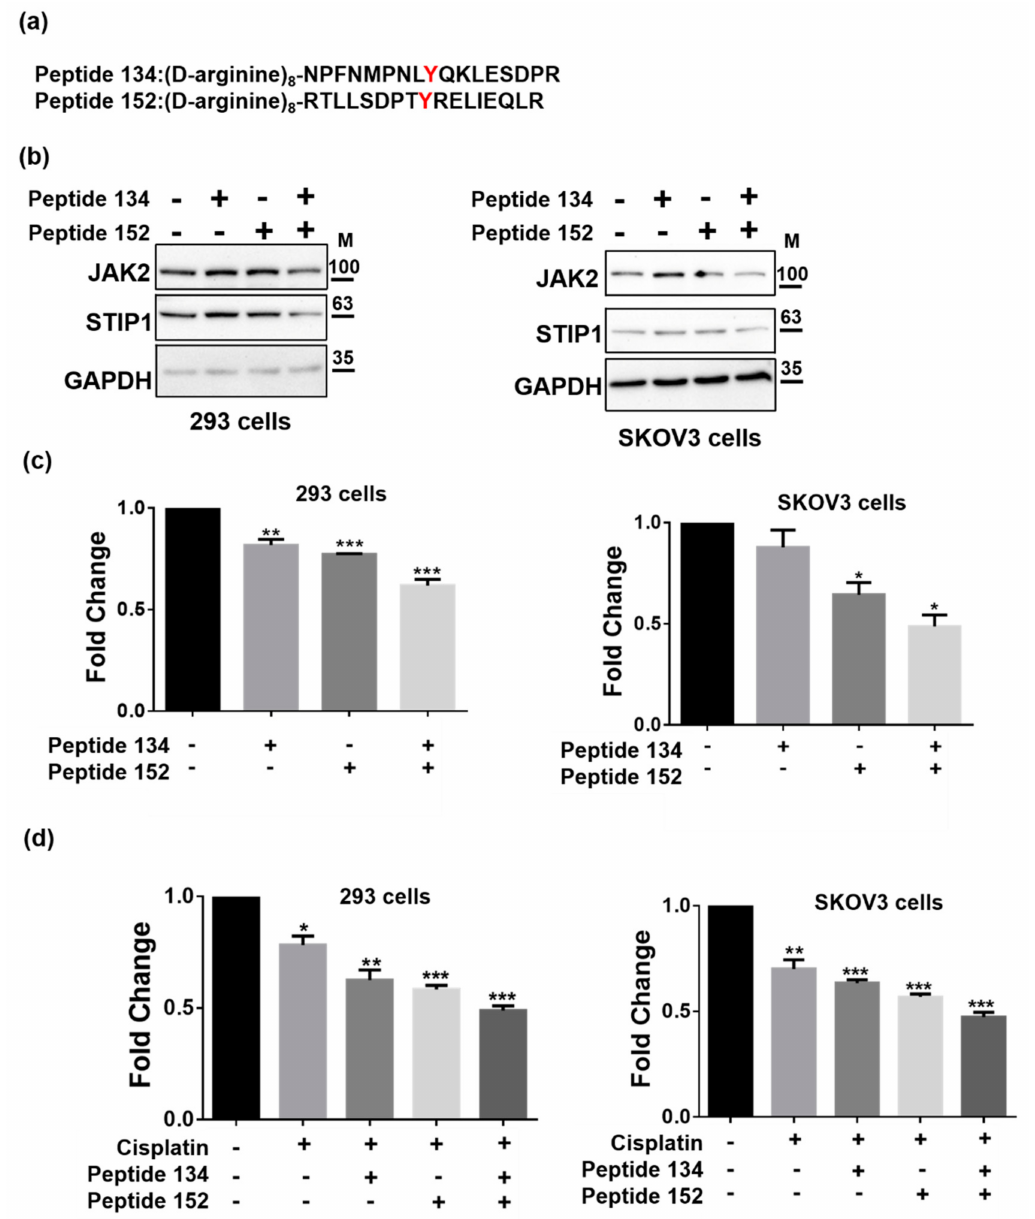
Figure 5. STIP1 Peptide 134 and Peptide 152 inhibit JAK2 and STIP1 expression. ( a ) Amino acid sequence of Peptide 134 and Peptide 152. Eight D-arginine residues were added to the N-terminal sequence of STIP1 peptides to serve as a cell membrane penetration signal. ( b ) HEK293 or SKOV3 cells were treated with Peptide 134 (10 µ M), Peptide 152 (10 µ M), or their combination (10 µ M) for 48 h. JAK2, STIP1, and GAPDH protein levels were determined by western blot. ( c ) HEK293 and SKOV3 cells were treated with Peptide 134 (10 µ M), Peptide 152 (10 µ M), or their combination (10 µ M) for 48 h. Cell viability was determined using the CCK-8 assay according to the manufacturer’s protocol. ( d ) HEK293 and SKOV3 cells were treated with Peptide 134 (10 µ M), Peptide 152 (10 µ M), or their combination (10 µ M) for 24 h, and subsequently exposed to cisplatin (20 µ M) for additional 24 h. Cell viability was determined using the CCK-8 assay according to the manufacturer’s protocol. Results are expressed as mean ± standard errors from three independent experiments; * p < 0.05, ** p < 0.01, *** p <